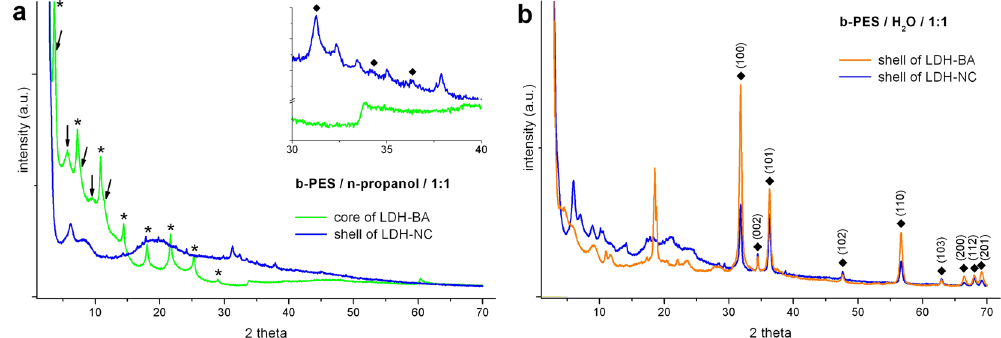
Figure 6. XRD patterns of LDH-BA and LDH-NC sediments after immersion in 10 M NaOH. ( a ) The core of LDH-BA (green) and the shell of LDH-NC (blue), both from n-propanol with equivalent charge ratio. Harmonic peaks caused by two populations of stacked LDH layers with different interlayer spacing are tagged with asterisks (1 st eight reflexes, d = 2.6 nm) and arrows (2 nd to 6 th peak, d = 4.7 nm) respectively. The insert shows an enlarged 2 θ section with those peaks being marked by lozenges that coincide with diffractions on ZnO lattice plains. ( b ) Shells of LDH-BA (orange) and LDH-NC (blue), both from water with an equivalent charge ratio. Peaks that are corresponding to the Wurtzite ZnO structure (cf. JCPDS card no. 36-1451 46 , Table S3) are tagged by lozenges and the corresponding lattice